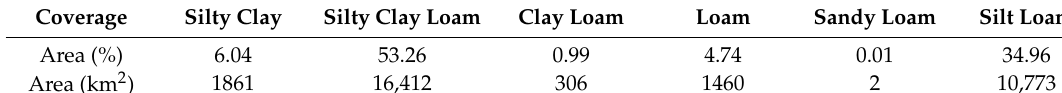
Table 6. Coverage per soil texture class in the study area.